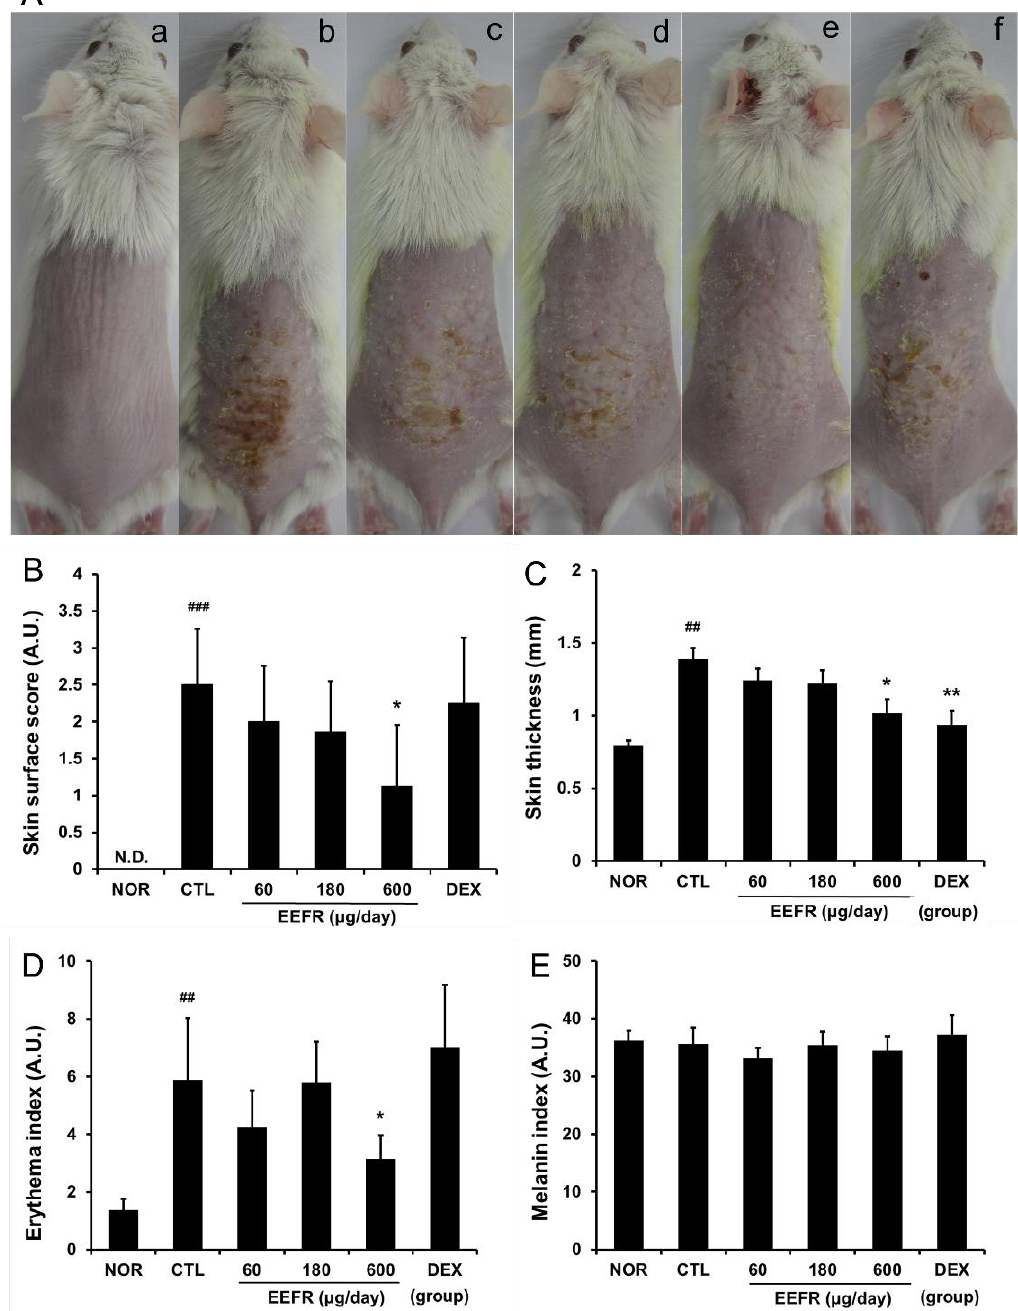
Figure 4. Effects of EEFR on skin lesions, thickness, and color in CD mice. Skin lesions were observed using a digital camera. ( a ), Treatment-naïve (NOR); ( b ), CD control (CTL); ( c ), 60 µg/day EEFR; ( d ), 180 µg/day EEFR; ( e ), 600 µg/day EEFR; and ( f ), 150 μg/day DEX ( A ). Skin surface scores were used to assess symptom severities ( B ). Weights of 5 mm diameter skin samples were measured using a micro-balance ( C ). Erythema and melanin indices were determined using a dermo-spectrophotometer ( D , E ). EEFR, ethanolic extract of Fraxinus rhynchophylla bark; DEX, dexamethasone. Results are presented as means ± standard deviation (SD)s. ## p < 0.01 and ### p < 0.001 vs. NOR; * p < 0.05 and ** p < 0.01 vs. CTL.